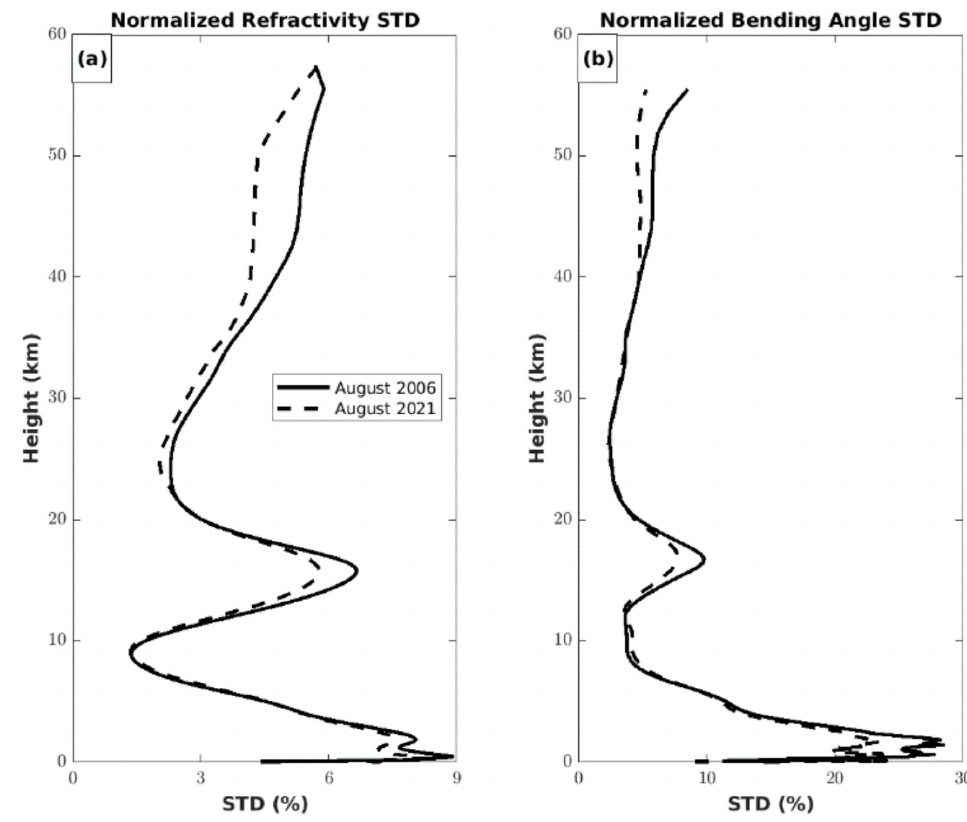
Figure 2. Standard deviations of ERA5 ( a ) normalized refractivity and ( b ) normalized bending angles. Solid profiles are August 2006 and dashed profiles are August 2021. Based on ERA5 data used in the 3CH error estimates and equalized C1 and C2 latitude